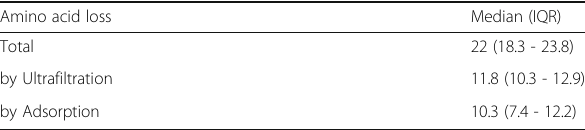
Table 103 (abstract A333). Estimated total amino acid loss